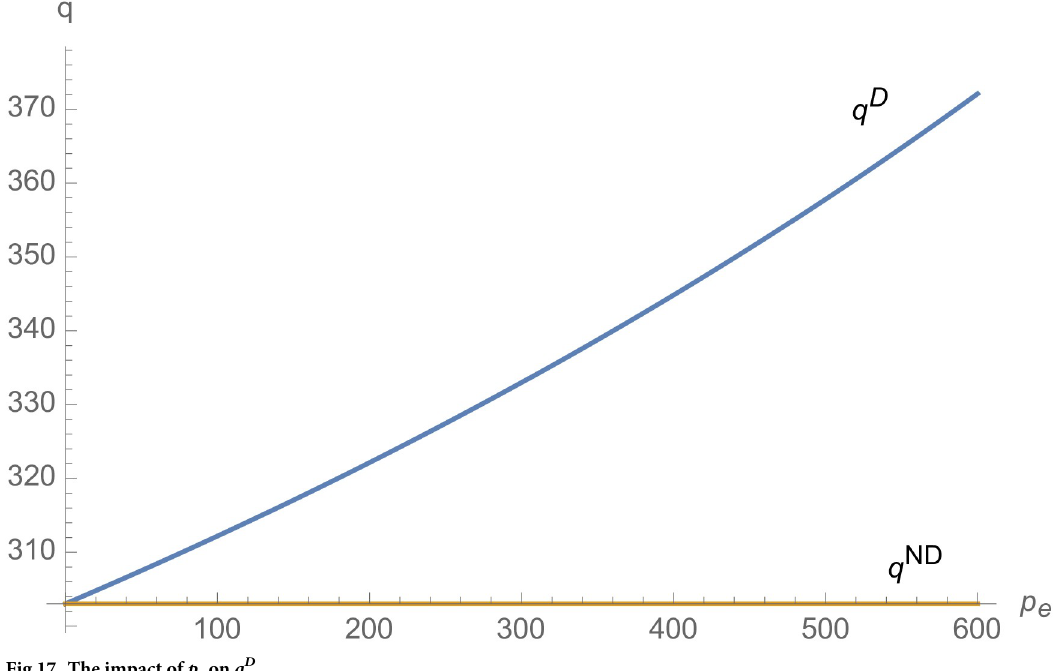
Fig 17. The impact of p